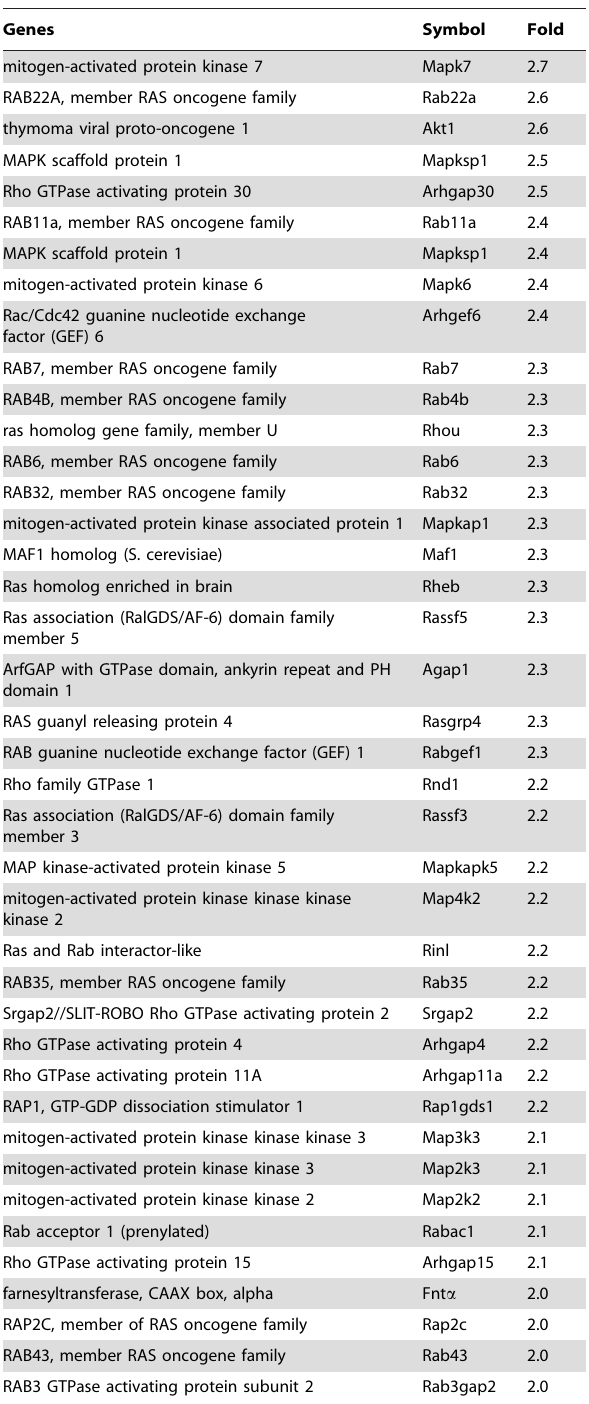
Table 4. Increases of additional monomeric low-molecular- weight Ras GTPase superfamily in lal 2 / 2 bone marrow